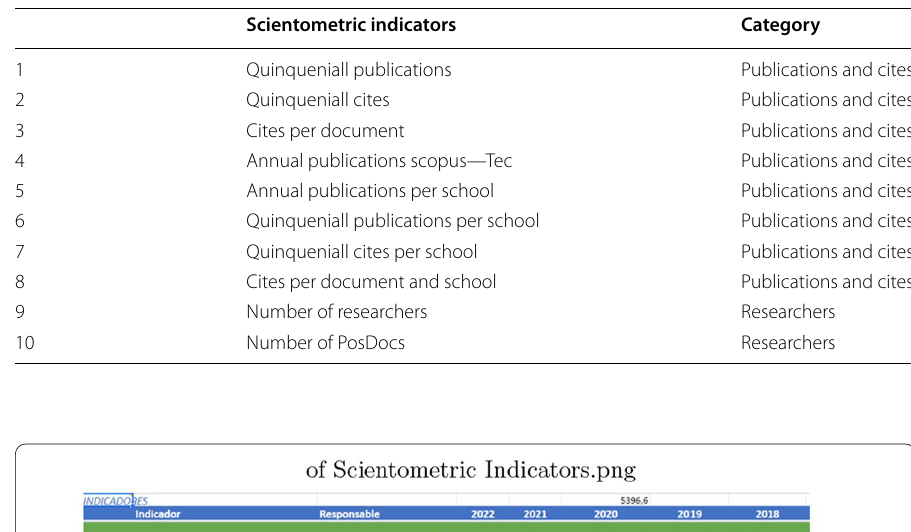
Table 1 Sample of 10 scientometric indicators for modeling